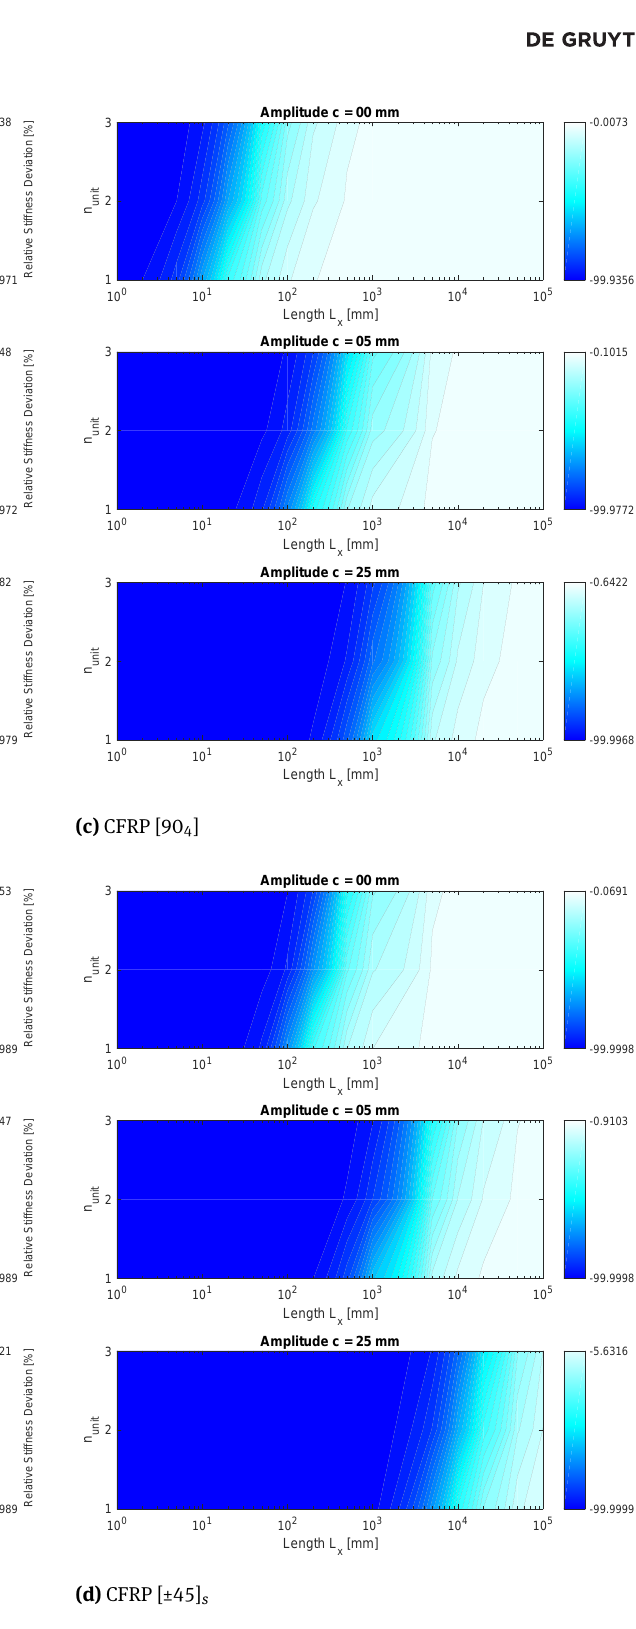
Figure 17: Load case 3 normalized apparent stiffnesses versus L x and n unit - for CFRP [90 4 ] and CFRP [±45]